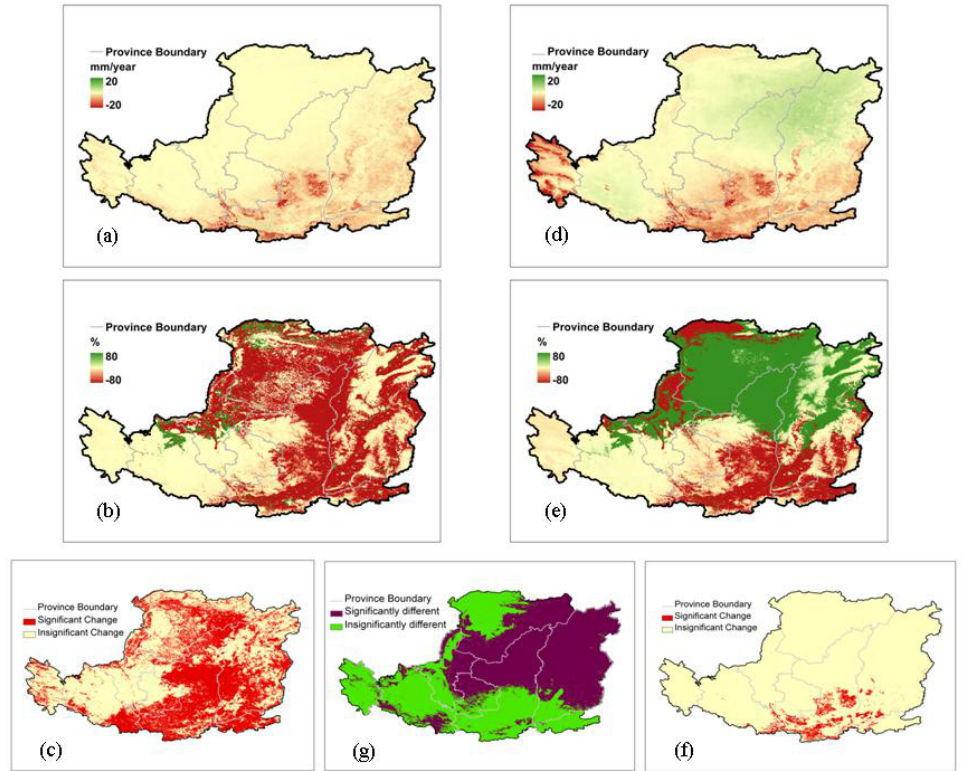
Fig. 5. (a) Spatial pattern of water yield change per year due to vegetation restoration; (b) its relative value; and (c) the significance of trend; (d) combined water yield change; (e) its relative value; and (f) the significance of trend in the period 2000–2007; and (g) the significance of Fig. 5 Spatial pattern of water yield change per year due to vegetation restoration (a), its the difference in water yield trend between combined change and land cover change relative value (b) and the significance of trend (c); combined water yield change (d), its relative value (e) and the significance of trend (f) in the period 2000–2007 and the